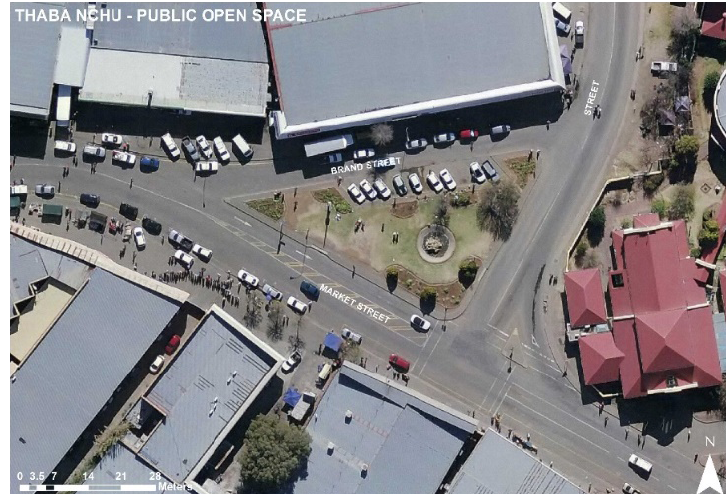
Figure 5. Driehoek Neighbourhood Park. Source: Kagisano (n.d.). The open design of DNP supports the ebbs and flows of human and vehicular traffic. As shown in Figure 6, inhab- itants transform the conceived DNP into a lived space, by overlaying its “physical space” and “making symbolic use of its objects” (Lefebvre, 1991, p. 39).